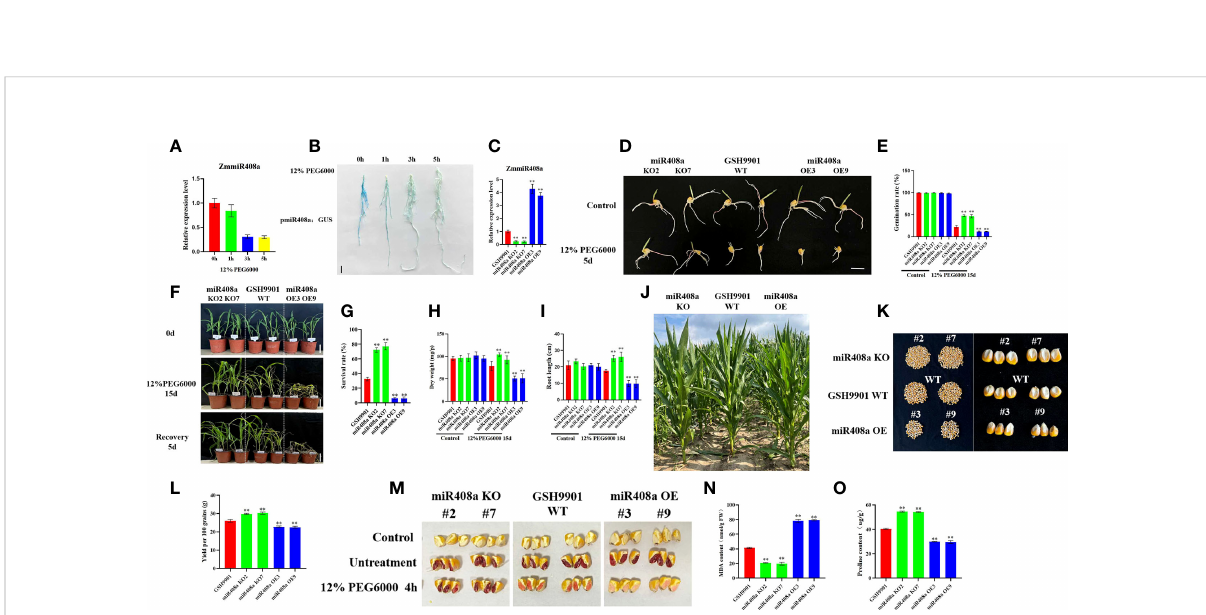
FIGURE 7 Analysis of phenotype and physiological and biochemical indexes of ZmmiR408a transgenic plants under drought stress. (A) Expression pattern analysis of ZmmiR408a in roots upon drought treatment. (B) Histochemical analysis of ZmmiR408a promoter: GUS transgenic maize roots were done under 0-h, 1-h, 3-h, and 5-h drought treatment. (C) Real-time quantitative PCR analysis of the expression level of ZmmiR408a gene in miR408a-OE and miR408a-KO plants. (D, E) Seed germination phenotypes of transgenic lines and wild-type plants under non-treatment and 12% PEG6000 treatment for 5 days. The scale bar represents 2 cm. (F, G) Analysis of wilting degree and recovery ability of transgenic lines and wild-type plants under drought treatment for 15 days and recovery for 5 days. All the plants were grown in a greenhouse at 25 ± 2°C under a 16-h light/8-h dark photoperiod. (H) Dry weight of wild-type, miR408a-KO, and miR408a-OE seedlings under normal and drought stress conditions. (I) Root length of wild-type, miR408a-KO, and miR408a-OE plants recorded after 15 days of non-treatment and drought treatment. (J) Phenotypes of plant height of wild-type, miR408a-KO and miR408a-OE plants under drought treatment in the fi eld. (K, L) Grain phenotype and 100-seed weight analysis of wild-type, miR408a-KO, and miR408a-OE plants under drought treatment. (M) Seed vigor of wild-type, miR408a-KO and miR408a-OE plants under 12% PEG6000 treatment. A total of 0.4% TTC solution was used for staining observation of seed vigor. Control: maize kernels boiled in boiling water for 2 h; Untreatment: maize kernels without drought treatment. (N, O) Malondialdehyde (MDA) content and Proline (Pro) content in leaves of wild-type, miR408a-KO, and miR408a-OE plants under drought treatment. Data were expressed as the mean of triplicate values and error represented the SD, p < 0.05 (*) and p < 0.01